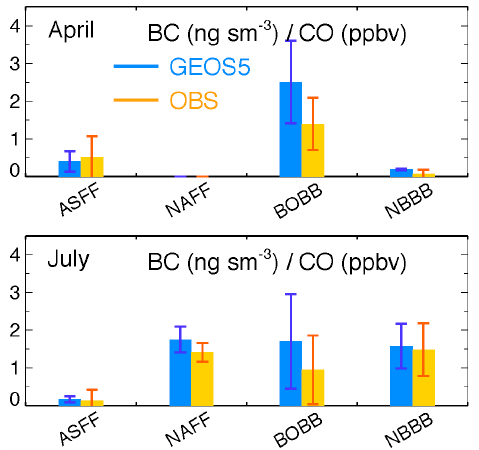
Figure 7: The statistical ratios between the mixing ratios of BC [ng sm -­‐3 ] to CO [ppbv] over ARCTAS A (top) and ARCTAS-­‐B (bottom) campaigns. The blue box represents model ratio and yellow box represents observed ratio. The ratios are sorted based on the dominant model CO tag in the measured pollution.